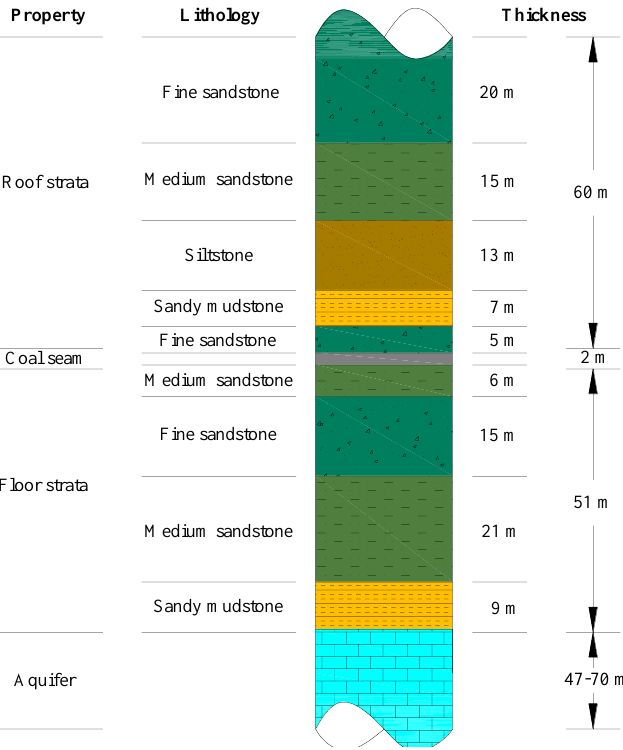
Figure 9. The geolithological division of the coal and rock strata.